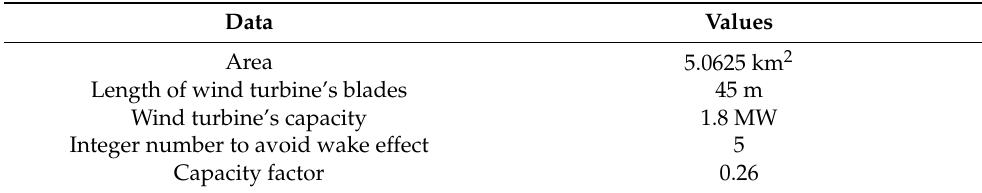
Table 3. Summary of the data used for the simulation of the 36-nodes virtual grid.